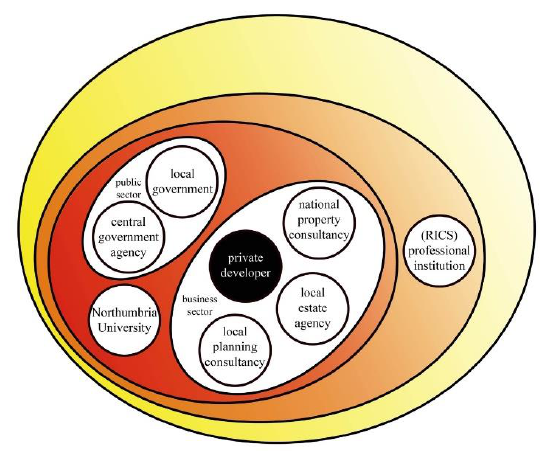
Figure 13. Mapping of postgraduate Urban and Regional Planning Level 7 Module.